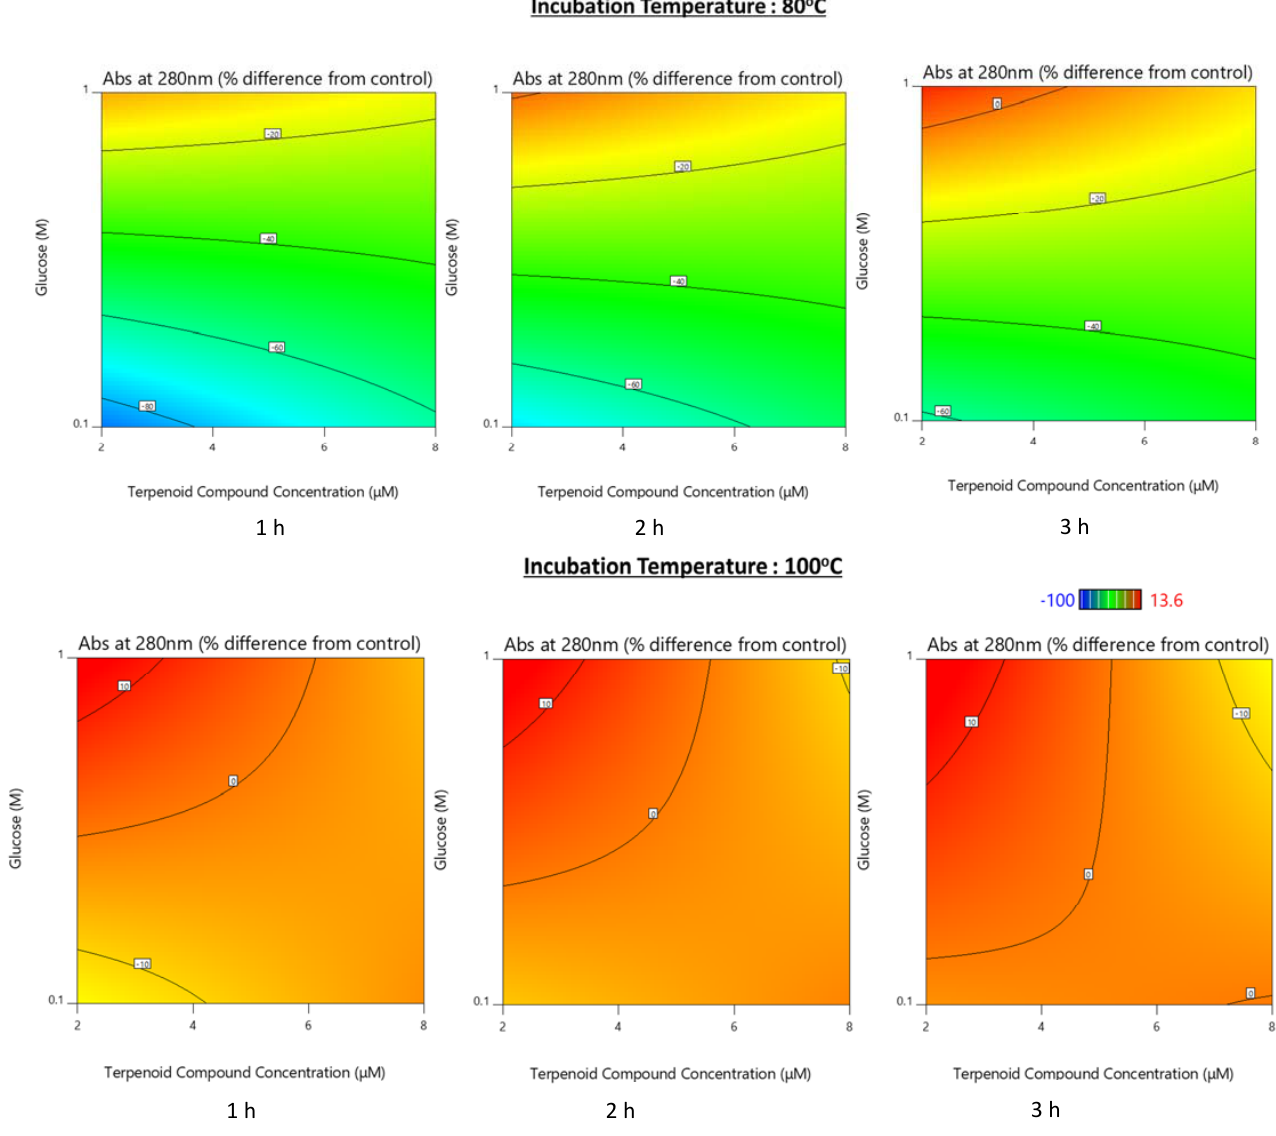
tion ( p = 0.03), terpenoid compound and its concentration ( p = 0.02), glucose concentration and temperature ( p = 0.007), glucose concentration and terpenoid compound ( p = 0.02) as well as terpenoid compound and temperature ( p =